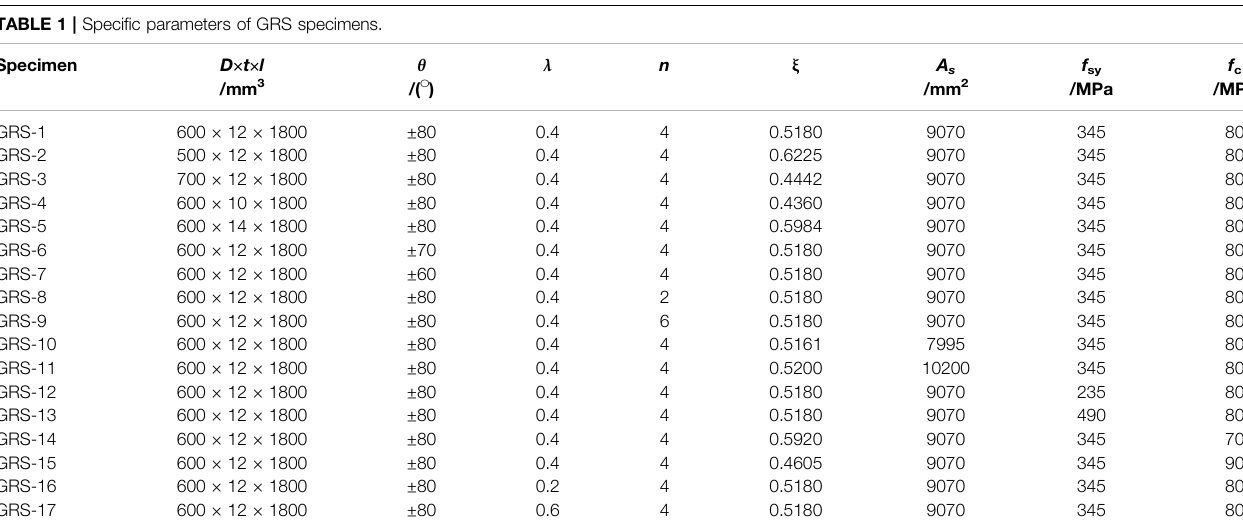
TABLE 1 | Speci fi c parameters of GRS specimens.